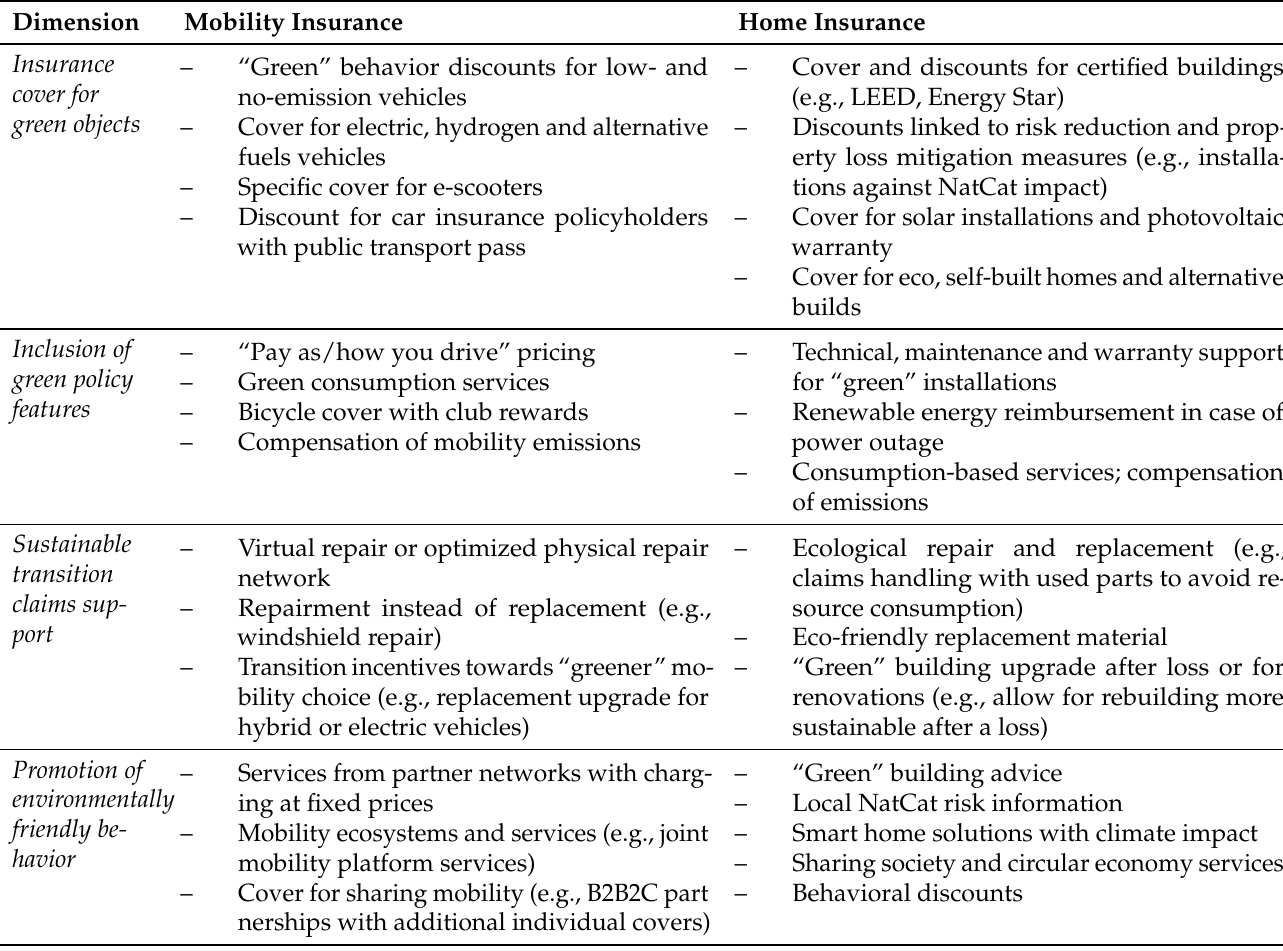
Table 2. Examples of sustainable mobility and home insurance propositions (adapted from Allianz and Euler Hermes 2020; AutoSense 2022; Capgemini 2021; Laka 2022; Mills 2009; Sharely 2022; Thingsy 2022; UNEPFI 2007; VCS 2020; Zurich 2022, see also Pugnetti et al.